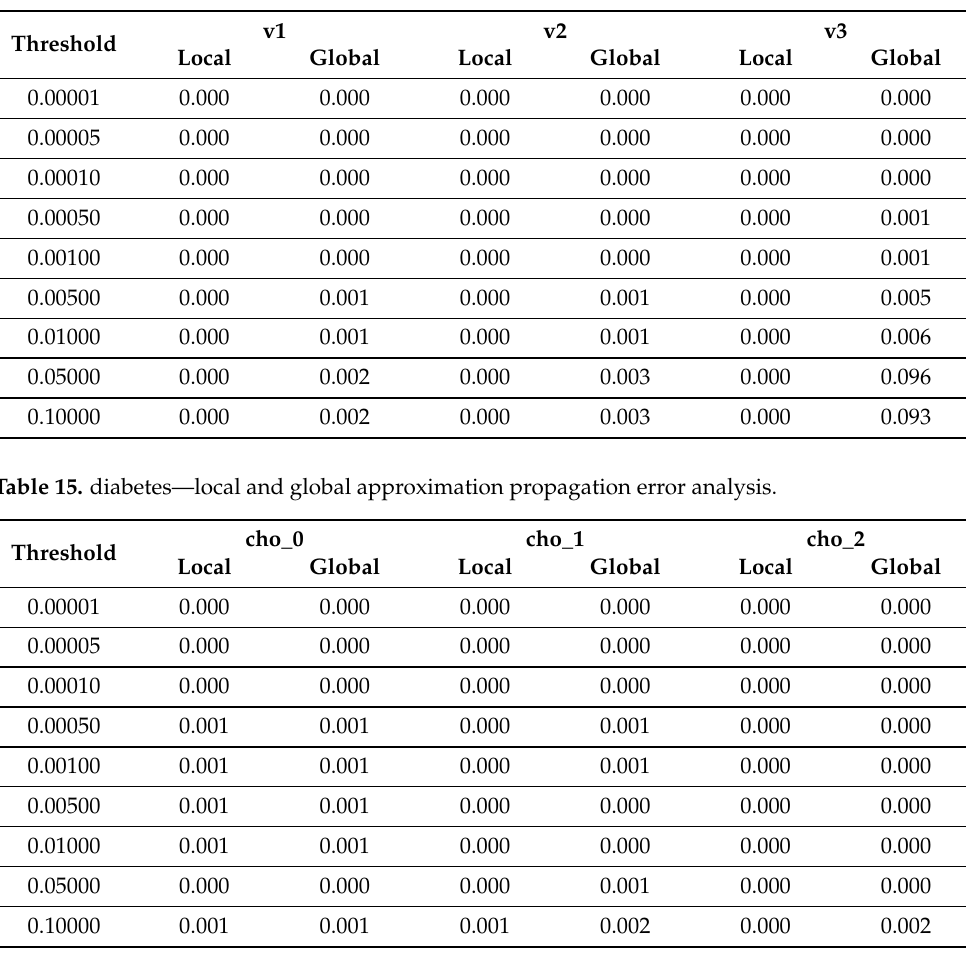
Table 14. munin—local and global approximation propagation error analysis. Threshold